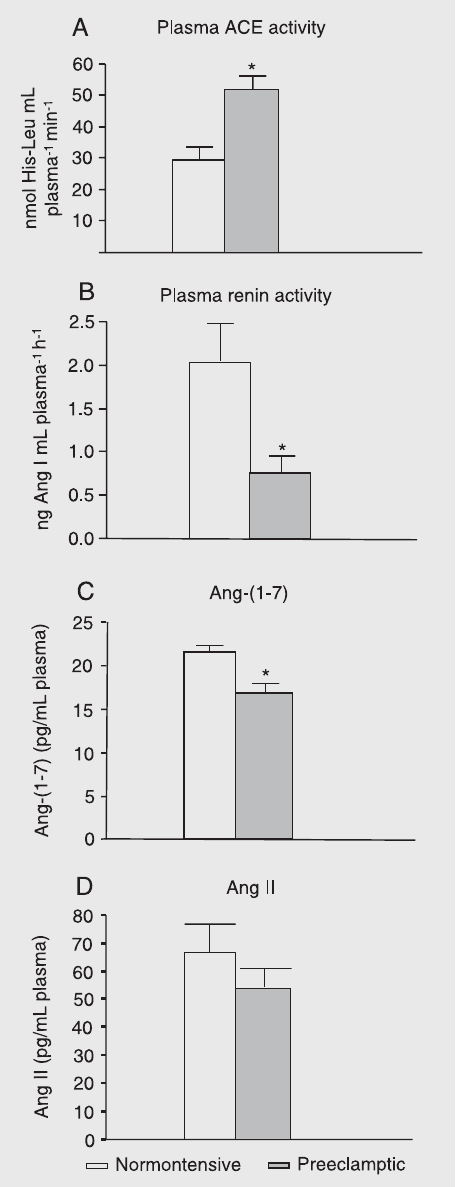
Figure 1. Plasma angiotensin- converting enzyme (ACE) activ- ity (A), plasma renin activity (B), plasma angiotensin-(1-7) (Ang- (1-7)) levels (C), and plasma an- giotensin II (Ang II) levels (D) of normotensive and preeclamptic pregnant women. *P < 0.05 compared to normotensive preg- nant women (Student t